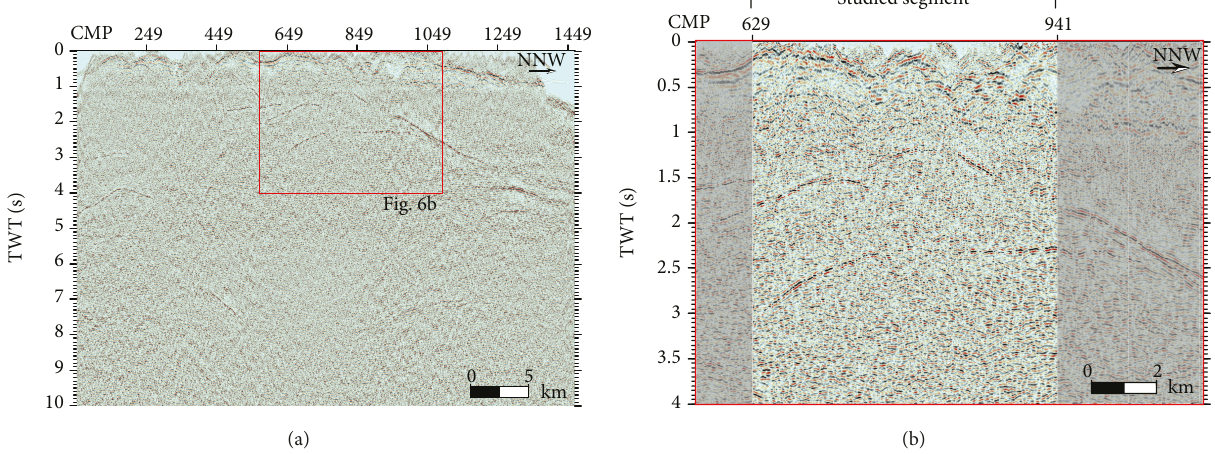
Figure 6: (a) CROP-18A stacked section. (b) Zoom of the CROP-18A stacked section of Figure 6(a). Stacked data in the CMP range from 629 to 941 were compared with the synthetic stacked sections. The trace of the studied segment of the CROP-18A section is reported in Figure 5. Table 2: Interval velocities applied for the modelled units and their ranges from literature data. Interval velocity of the geological unit below the K-horizon represents a major issue for the seismic exploration in the Larderello area, and it depends on the geological-geophysical interpretative hypotheses assigned to the K-horizon itself (see text for details).